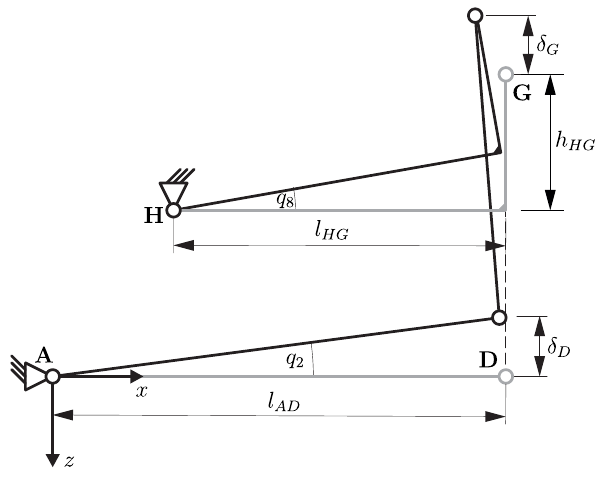
Figure 3. Kinematically equivalent mechanism of the weighing cell in Fig.